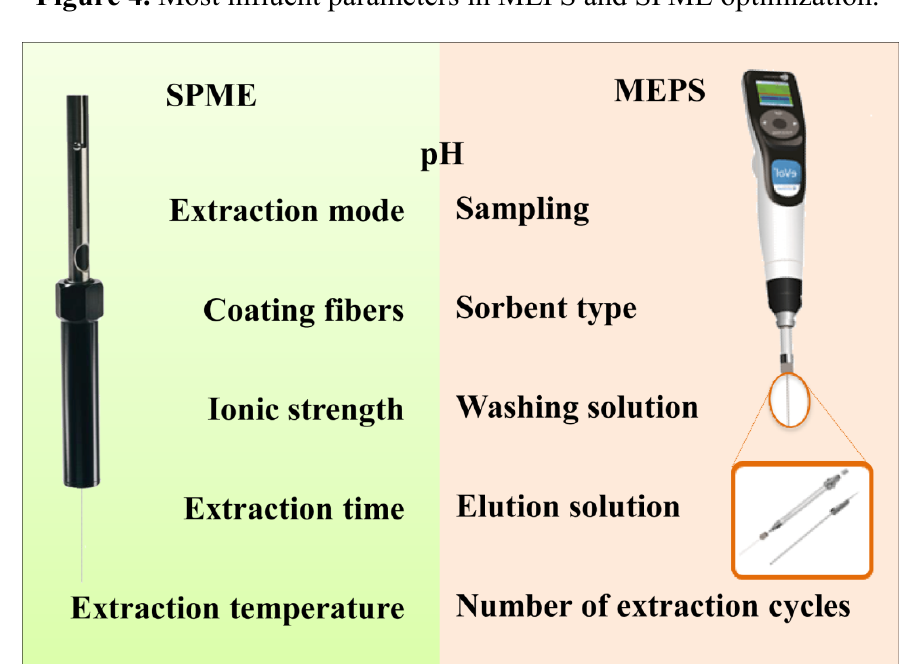
Figure 4. Most influent parameters in MEPS and SPME